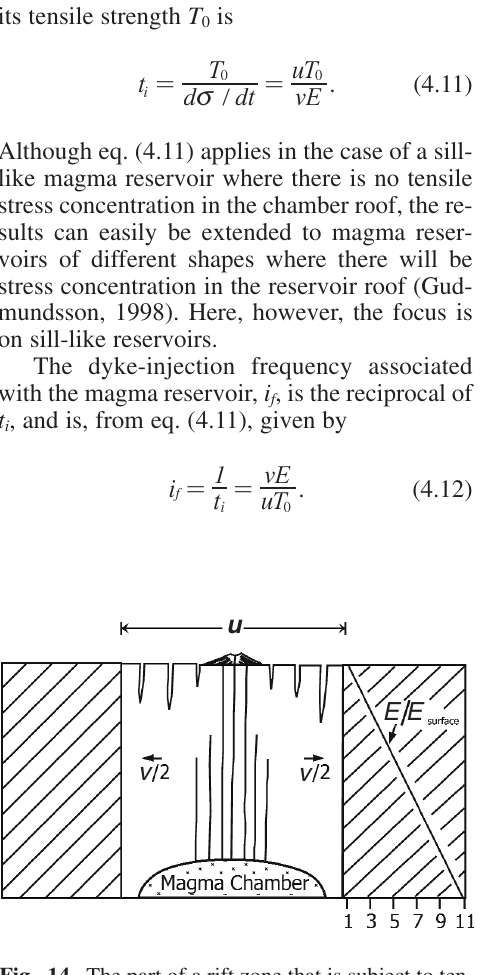
Fig. 14. The part of a rift zone that is subject to ten- sile strain during plate movements (plate pull) with a total spreading (opening) rate of v (half rate v/ 2) has the width u ( cf. Gudmundsson, 1990). In this model, the crustal stiffness (Young’s modulus, E ) increases linearly with depth; the surface modulus being E surface .